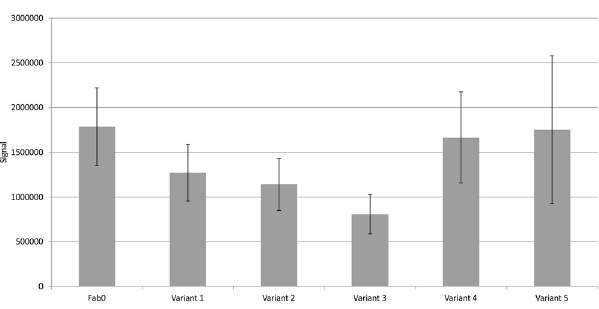
Figure 5. Immunoreactivity of Fab displaying phage towards immobilized digoxigenin. The average signals of the parent gene Fab0 and the variants 1–5 from three phage productions are